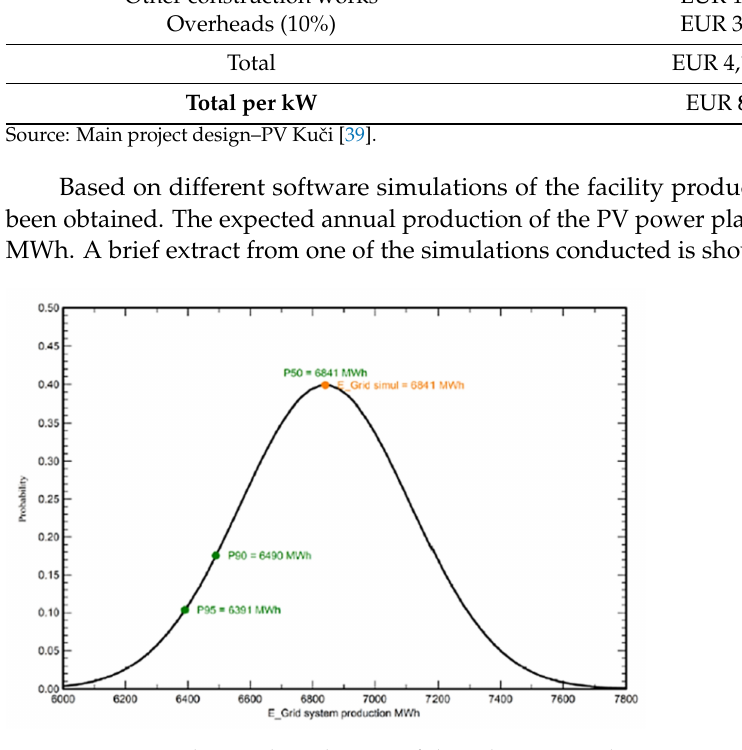
Figure 4. Expected annual production of the solar power plant. Source: Main project design–PV Kuˇci